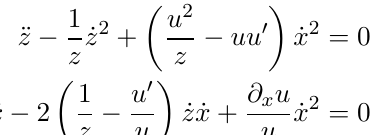
Figure 2 . Various curves drawn in both the global disk (left) and the Poincar(cid:19)e patch (right). then